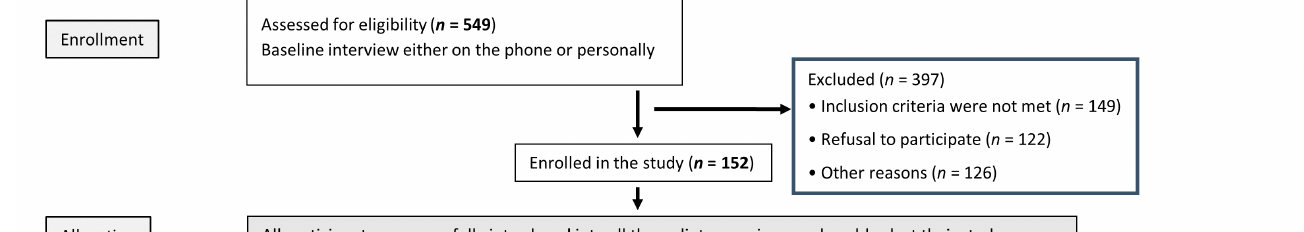
Table 1. Baseline characteristics of the patients comprising the three intervention groups.